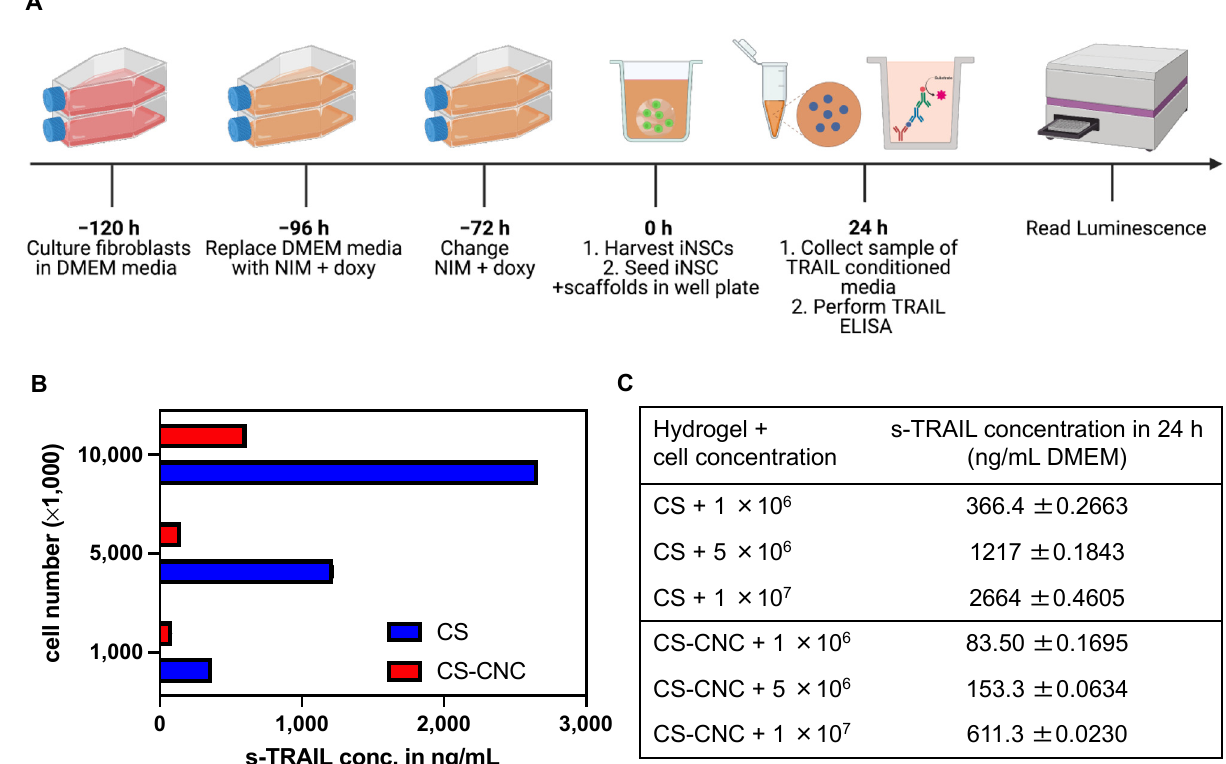
Figure 7. Impact of CS-CNC hydrogels on s-TRAIL release. ( A ) Schematic illustration of in vitro s-TRAIL release experimental design. ( B ) Graphical representation of s-TRAIL concentration released from iNSC-hydrogels post 24-h incubation ( n = 7; 100 µ L samples). ( C ) Summary table of s-TRAIL concentration from cell-laden hydrogel scaffolds.